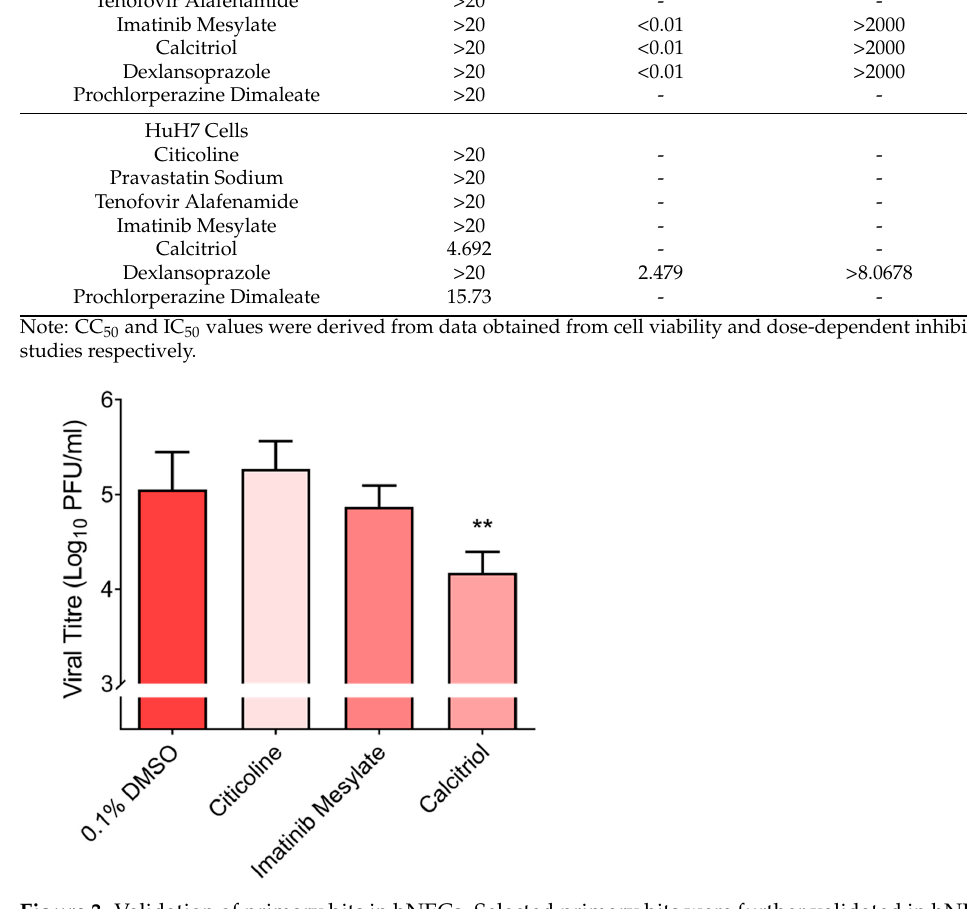
Figure 3. Validation of primary hits in hNECs. Selected primary hits were further validated in hNECs. Cells were either pre-treated with 10 µ M citicoline prior to SARS-CoV-2 infection or treated following SARS-CoV-2 infection with 10 µ M imatinib mesylate and 10 µ M calcitriol. One-way ANOVA and Dunnett’s post-test were used to determine statistical differences, with ** denoting that p < 0.01. Error bars represent the standard deviation observed from the means of triplicates performed for dose-dependent inhibition